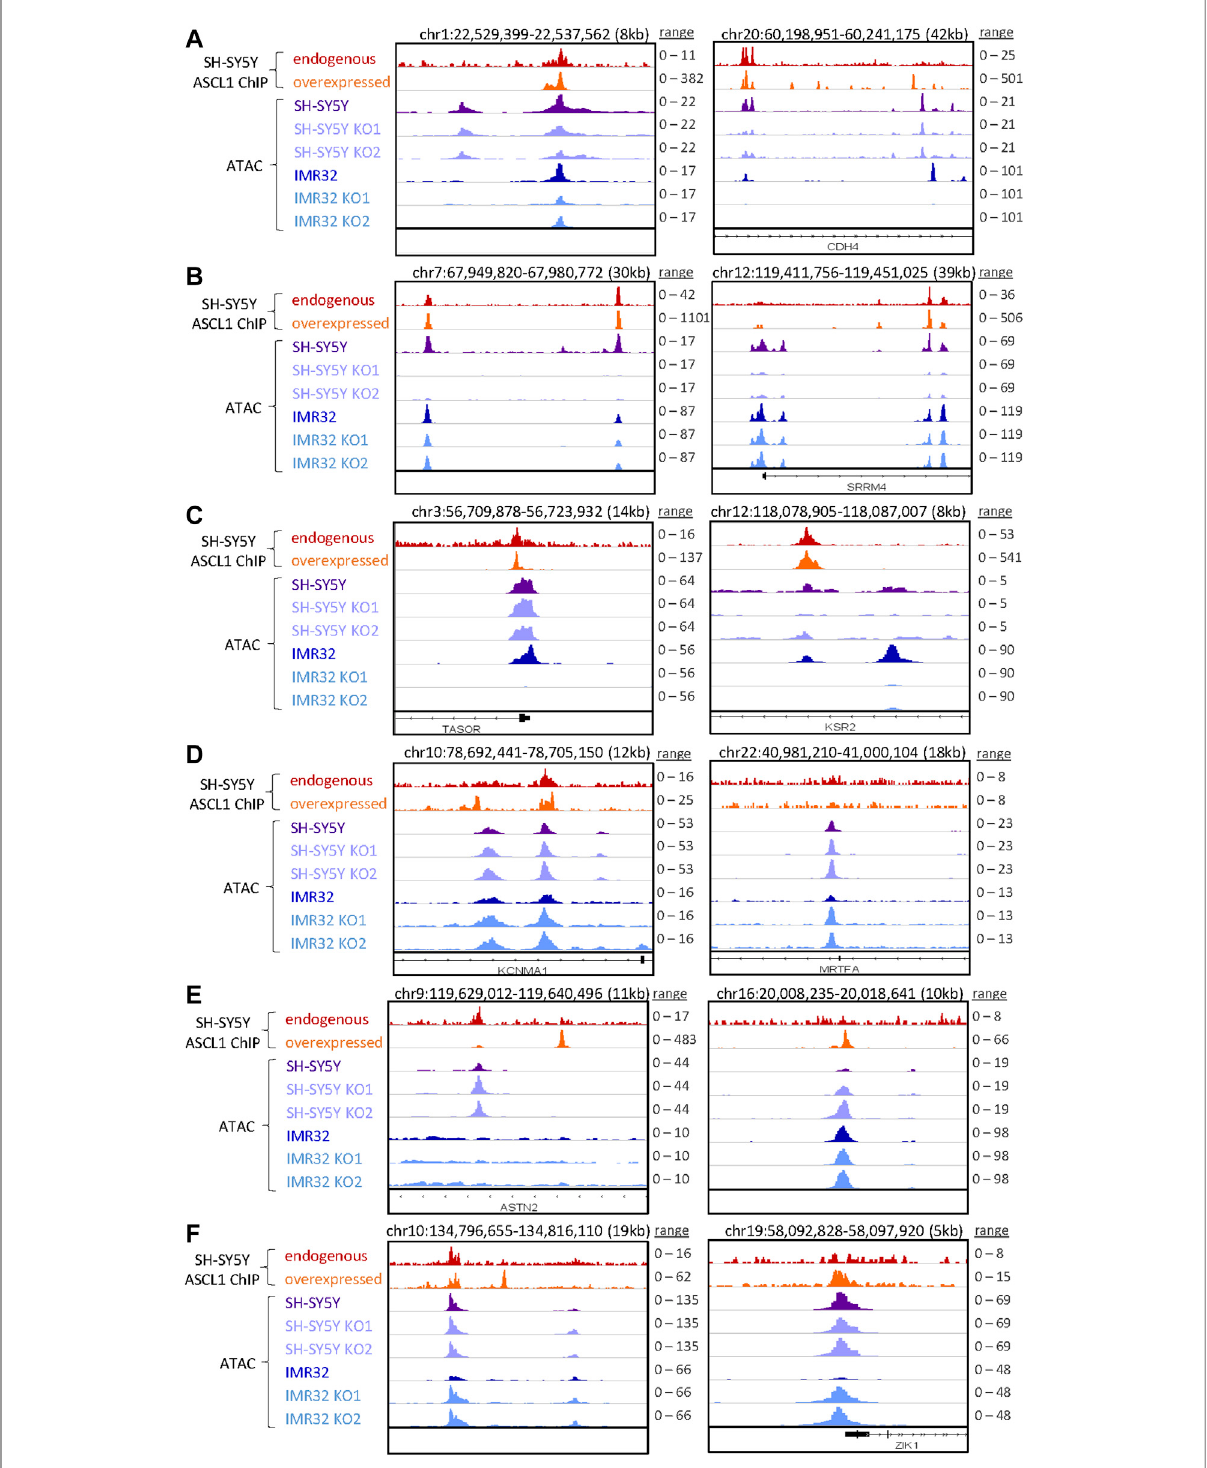
FIGURE 4 Speci fi c regions of altered accessibility after ASCL1 knockout. Genome browser tracks show examples of speci fi c regions with altered accessibility (accessibility is shown in purple for SH-SY5Y and blue for IMR32 cells, RPGC normalised) and the corresponding ASCL1 binding (red is endogenousASCL1binding,andorangeshowsthebindingofoverexpressedWTASCL1,RPKMnormaliseddatafromAlietal.,2020).Ineachplotthe